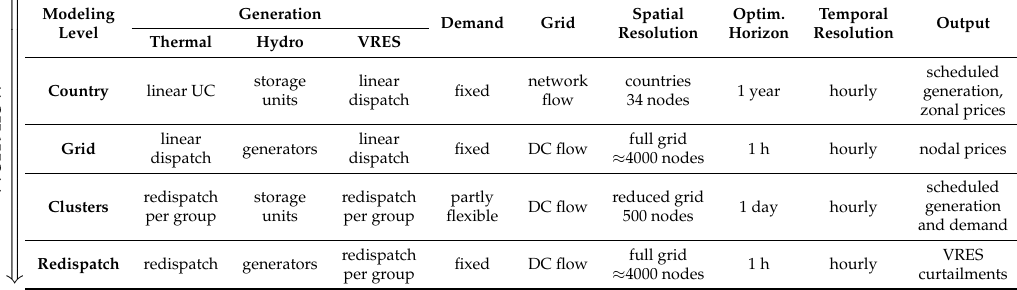
Figure 1. Sketch of the Europower methodology showing the data communication flows between the four modeling levels. Table 2. Modeling of the power system components for the four levels according to the Europower approach. The communication between the models is shown in Figure